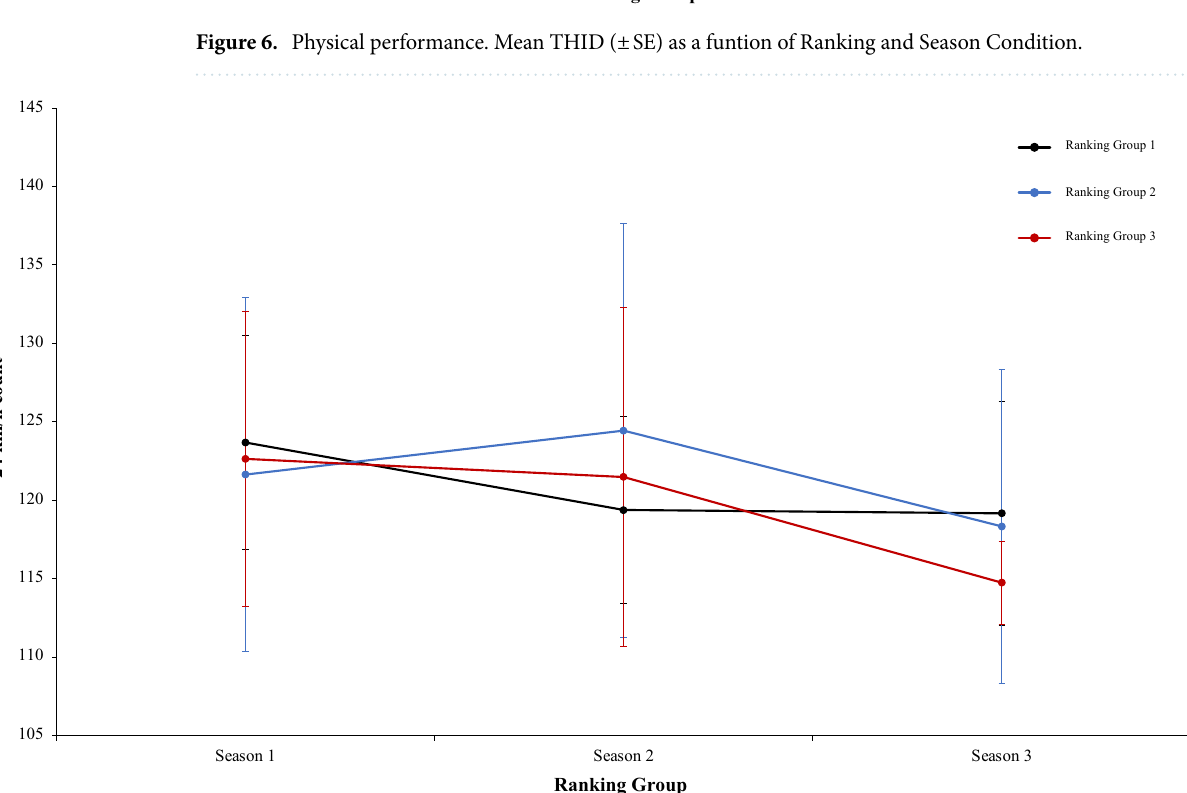
Figure 7. Physical performance. Mean TS (± SE) as a funtion of Ranking and Season